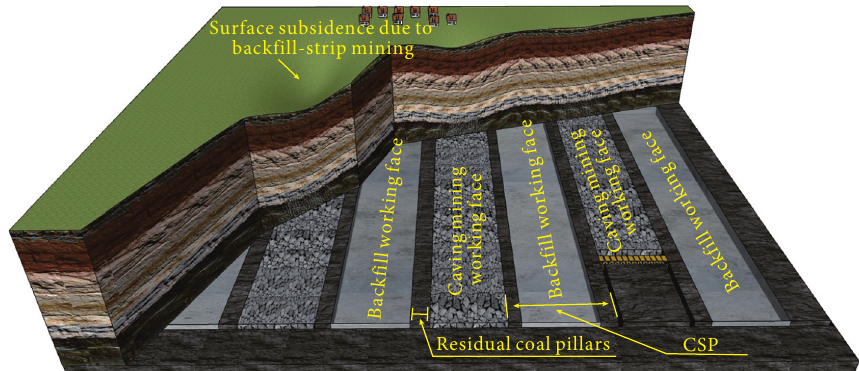
Figure 1: Diagram of backfill-strip mining.